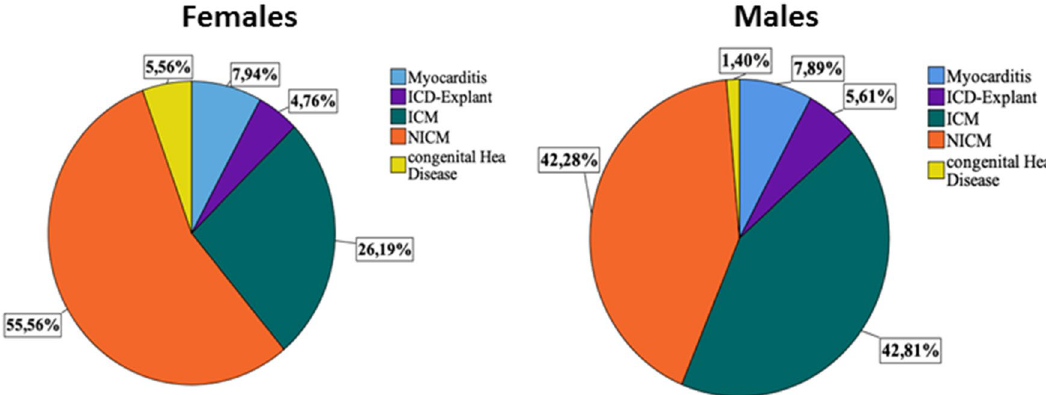
Figure 2. The indication for WCD use in males and females.